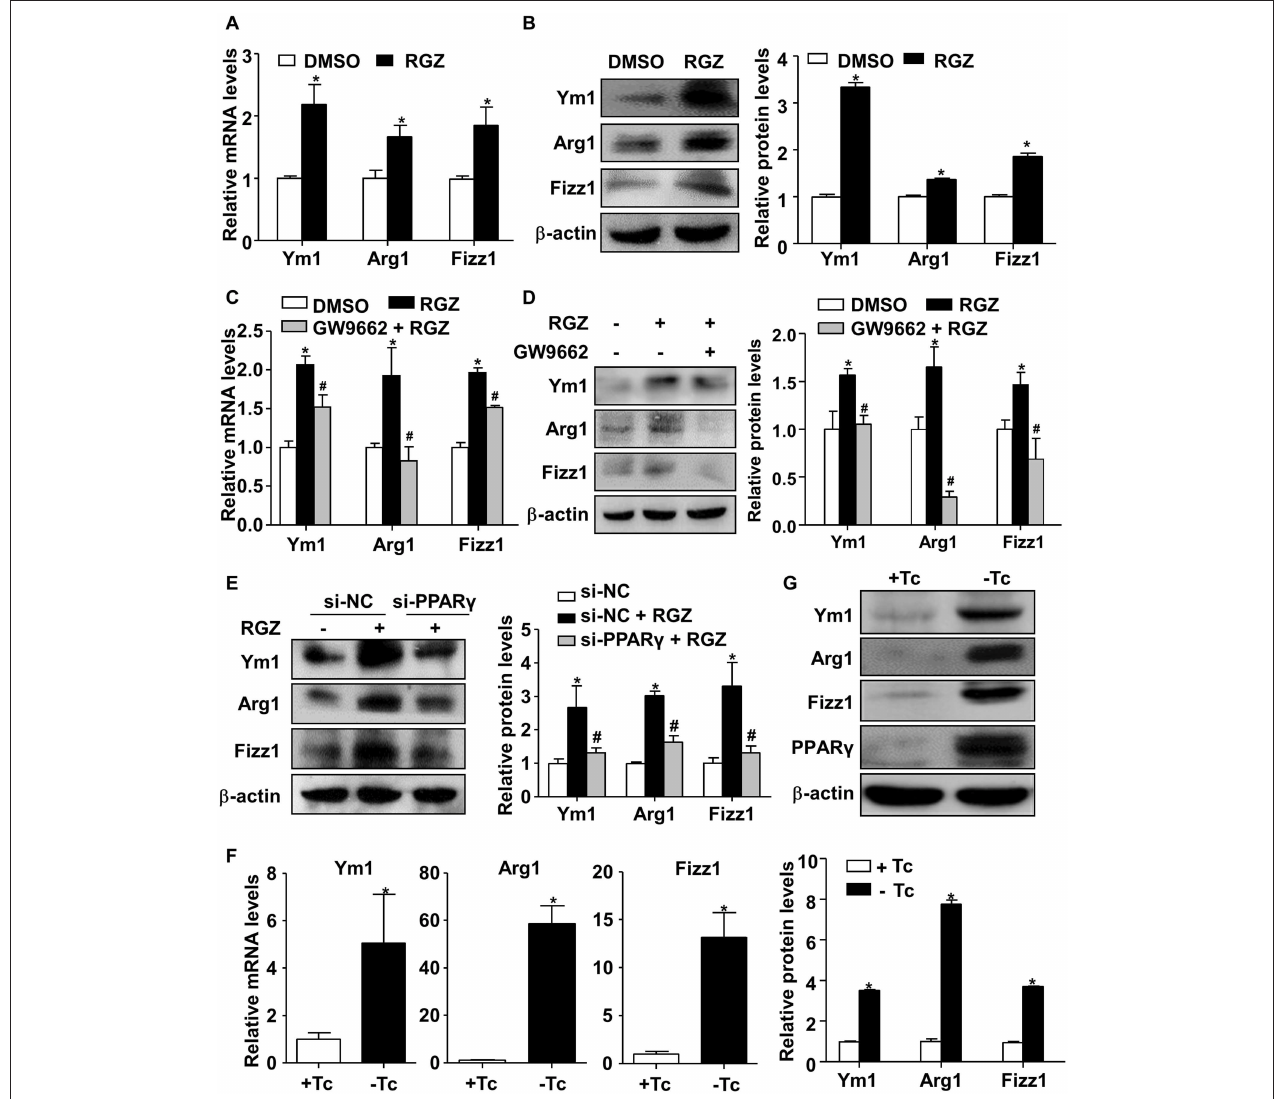
FIGURE 4 | PPAR γ transactivated Ym1, Arg1, and Fizz1 in RAW264.7 cells. (A) RAW264.7 cells were treated with RGZ (10 µ M) for 24h and DMSO as vehicle control. Total RNA was extracted and subjected to qRT-PCR for the assessment of Ym1, Arg1, and Fizz1 mRNA levels. (B) Ym1, Arg1, and Fizz1 protein levels were measured by using western blotting. (C) RAW264.7 cells were pre-treated with GW9662 (5 µ M) for 1h, then exposed to RGZ (10 µ M) for 24h. The mRNA levels of Ym1, Arg1, and Fizz1 were assessed by qRT-PCR. (D) The protein levels of Ym1, Arg1, and Fizz1 were measured by western blotting. (E) RAW264.7 cells were transfected with PPAR γ siRNA or NC siRNA for 24h, and then exposed to RGZ (10 µ M) for 24h. Protein levels of Ym1, Arg1, and Fizz1 were detected by using western blotting. (F) RAW264.7 cells were infected with Ad-PPAR γ and Ad-tTA with or without Tc (0.1 µ g/ml) for 48h. The mRNA levels of Ym1, Arg1, and Fizz1 were assessed by qRT-PCR. (G) The protein levels of PPAR γ , Ym1, Arg1, and Fizz1 were measured by western blotting. Data were shown as mean ± SEM, n = 3–4, * P < 0.05 vs. control; # P < 0.05 vs. RGZ or NC siRNA treated with RGZ.